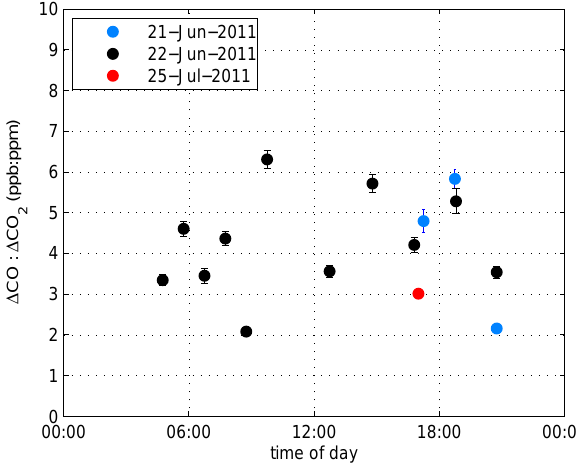
Fig. 2. 1 CO: 1 CO 2 ratios for groups of exit-entrance flasks sam- pled in parallel, shown against time of day. Different colours indi- cate different sampling